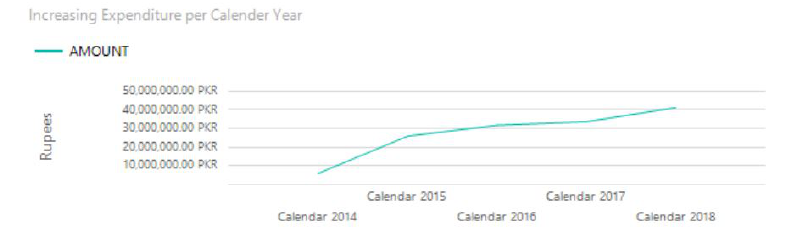
Figure 7. Yearwise insurance amount utilization.